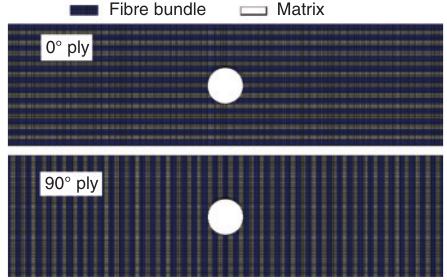
Figure 8: Meso-model of the 1#specimen.